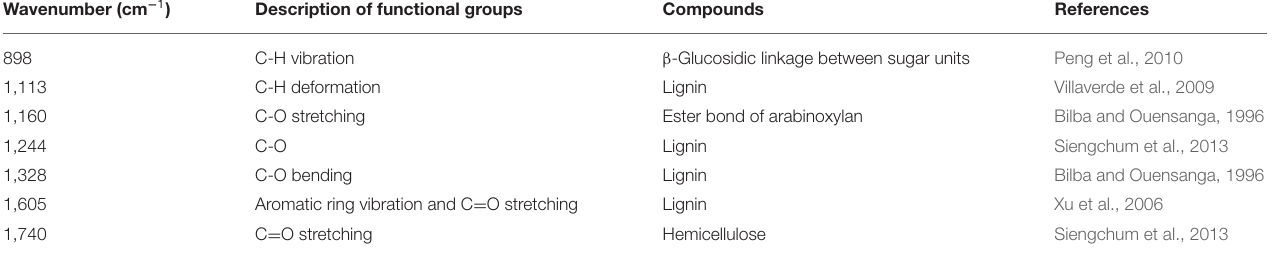
TABLE 2 | The main functional groups of the solid pyrolysis